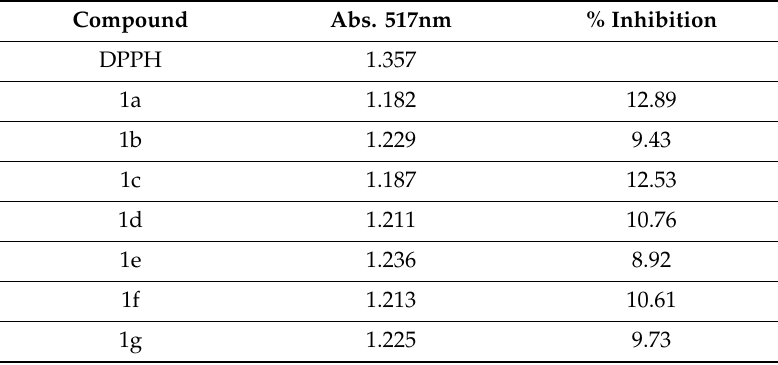
Table 7. Antioxidant activity of 1a – g